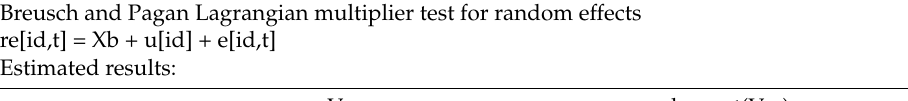
Table A3. Breusch and Pagan Lagrangian multiplier test for random effect for model 1. Breusch and Pagan Lagrangian multiplier test for random effects